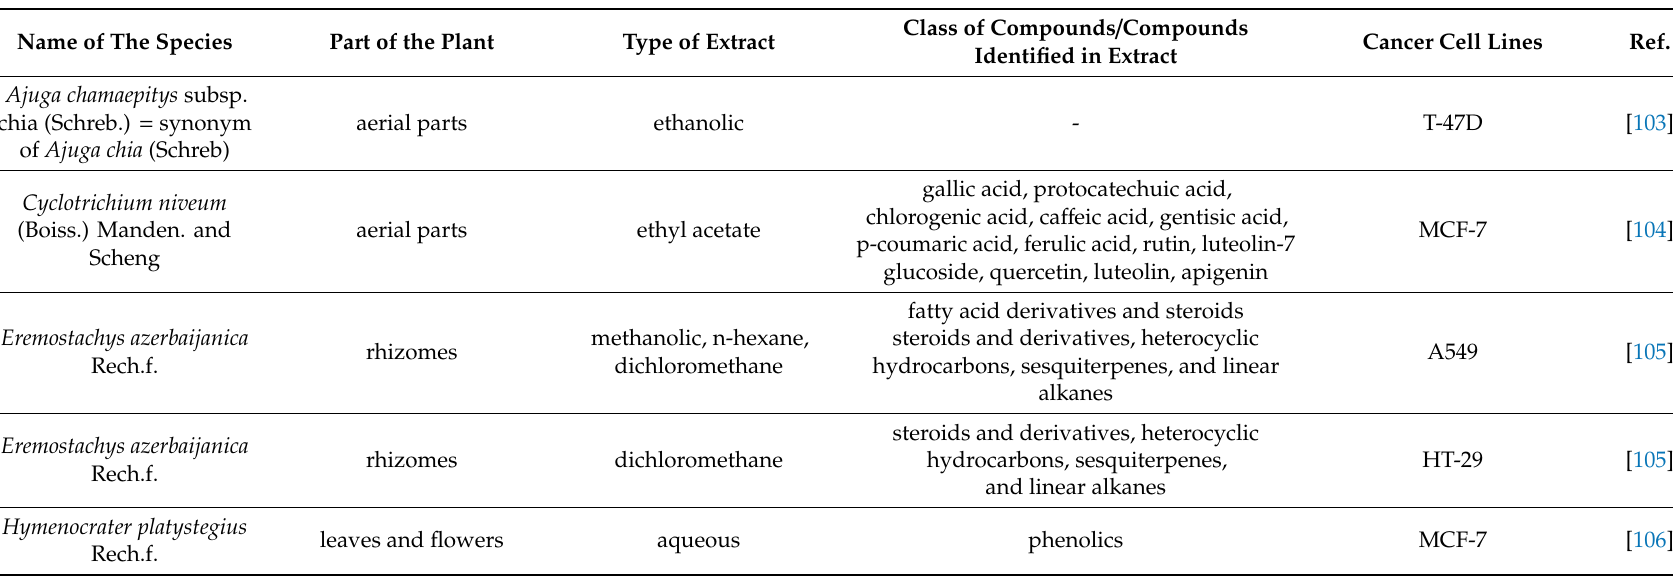
Table 1. Cytotoxic properties of selected extracts from the Lamiaceae family against lung, colon, breast, and prostate cancer